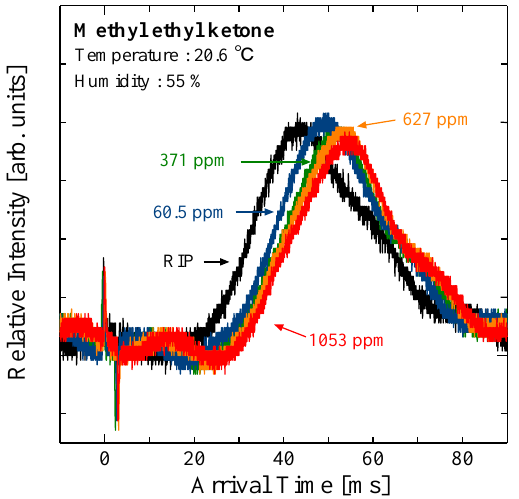
Figure 4. Arrival-time spectra of MEK (60.5, 371, 627, and 1053 ppm), measured with an electric field, E, of 186 V cm −1 . The reactant ion peak (RIP) is the background spectrum obtained from water cluster ions. Table 3. Relationship between MEK concentration and arrival time.